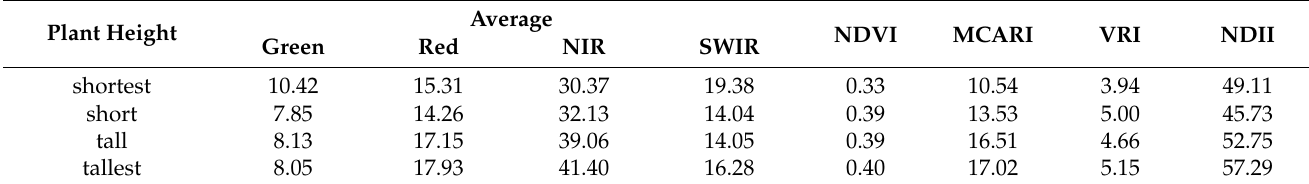
Table 6. The characteristic of vegetation indices of Pisang Klutuk using NDVI, VRI, MCARI, and NDII, respectively.